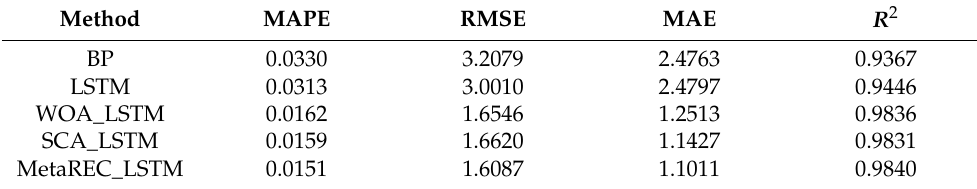
Table 7. Results of forecasting criteria evaluated by different